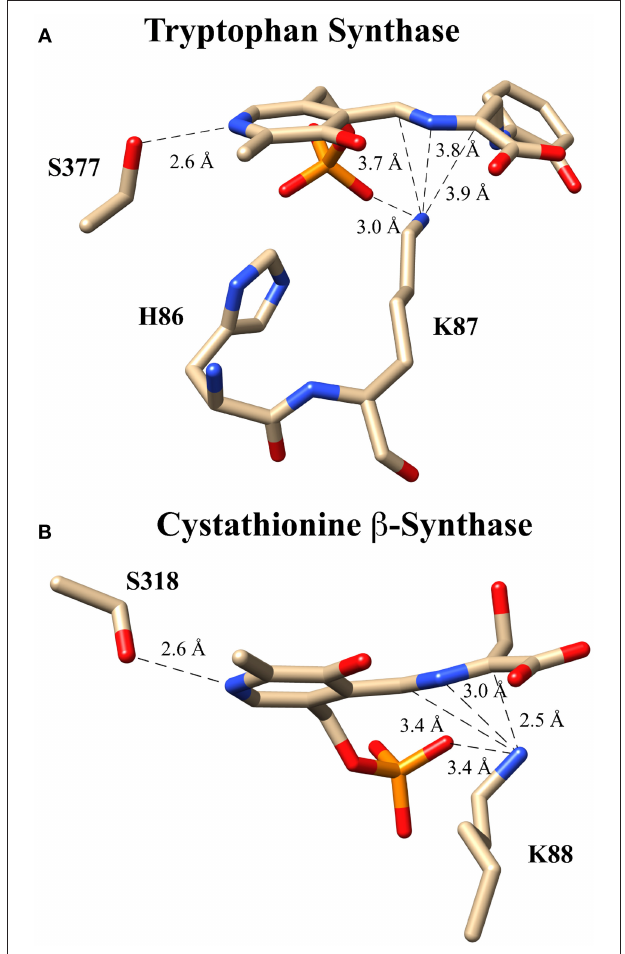
FIGURE 7 | Putative carbanionic intermediates as observed via x-ray crystallography. (A) Tryptophan synthase structure evidencing a “carbanonic intermediate” formed by addition of 2-aminophenol to the aminoacrylate intermediate (PDB code: 4HJP). This model is supported by Gaussian 09-based computations. (B) Cystathionine β -synthase structure featuring a similar “carbanionic intermediate” observed at pH 7 and hypothesized to be electrostatically stabilized by K88 (PDB code: 3PC4).